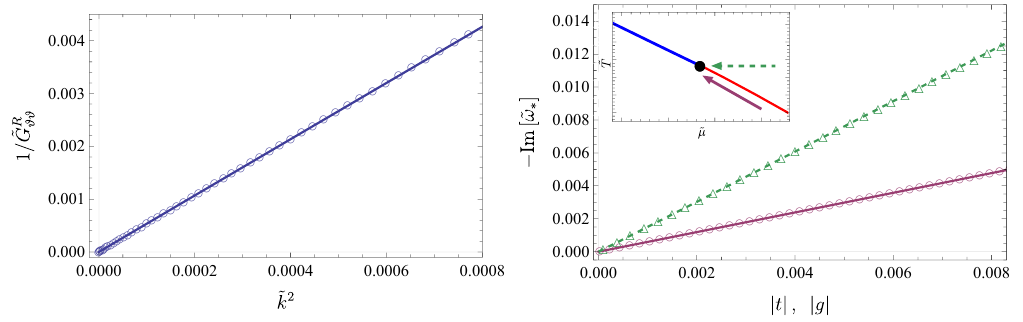
Figure 9 . The critical behavior of 1 / ˜ χ ch (left panel) and − ˜ k 2 circles and solid purple line) and the path with t = 0 fixed (open triangles and dashed green line). The inset shows the phase diagram and two arrows denote the two different paths.